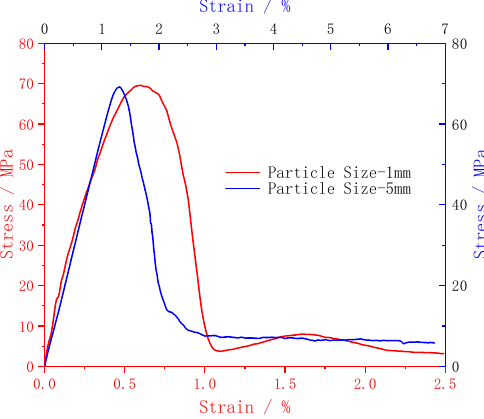
Figure 3. Stress–strain curve of concrete specimen.